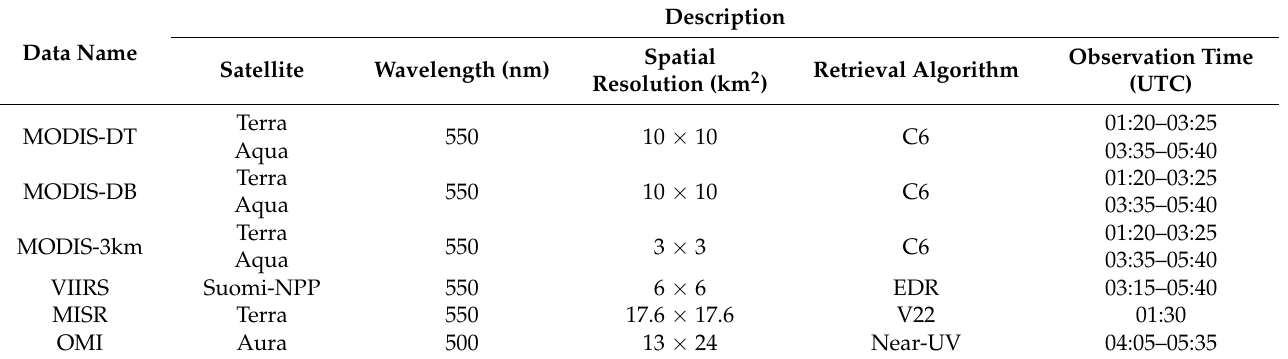
Table 1. Detail description of satellite AOD values used in this study.